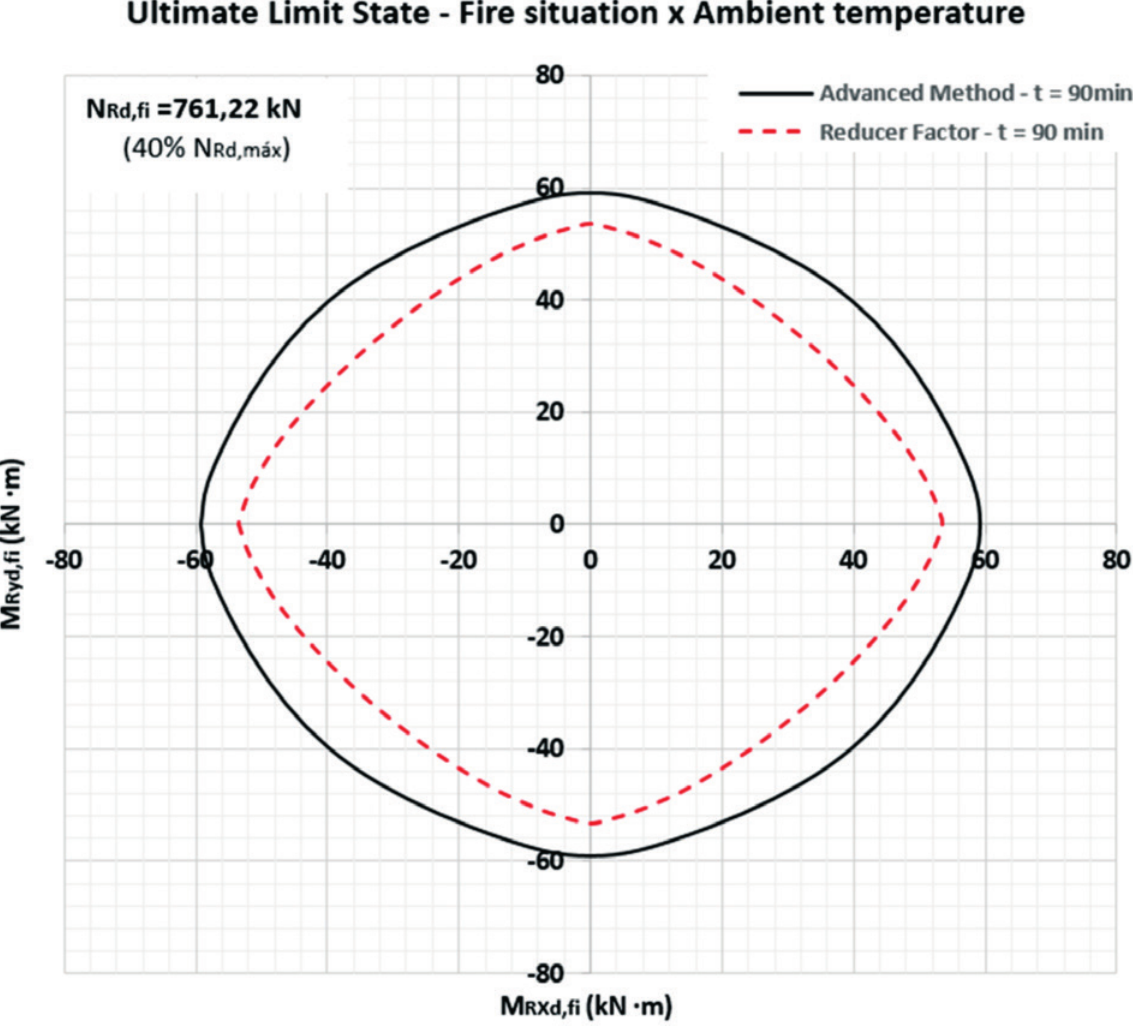
Figure 14 Achieved result comparison, by the approximate method, using the reducer factor ‘fr’, with the result achieved by fire advanced